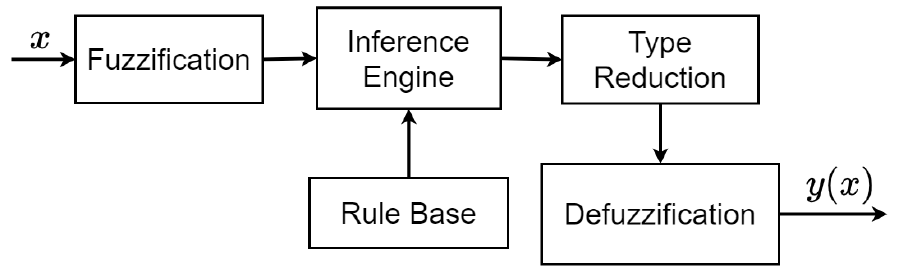
Figure 2. Type-II fuzzy logic